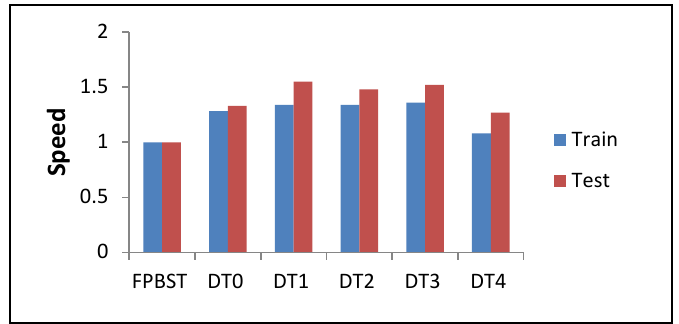
Figure 9. Illustration of data average from Table 7 (speed-up results—training and testing phases—of the proposed methods DT0–DT4 compared to the FPBST).